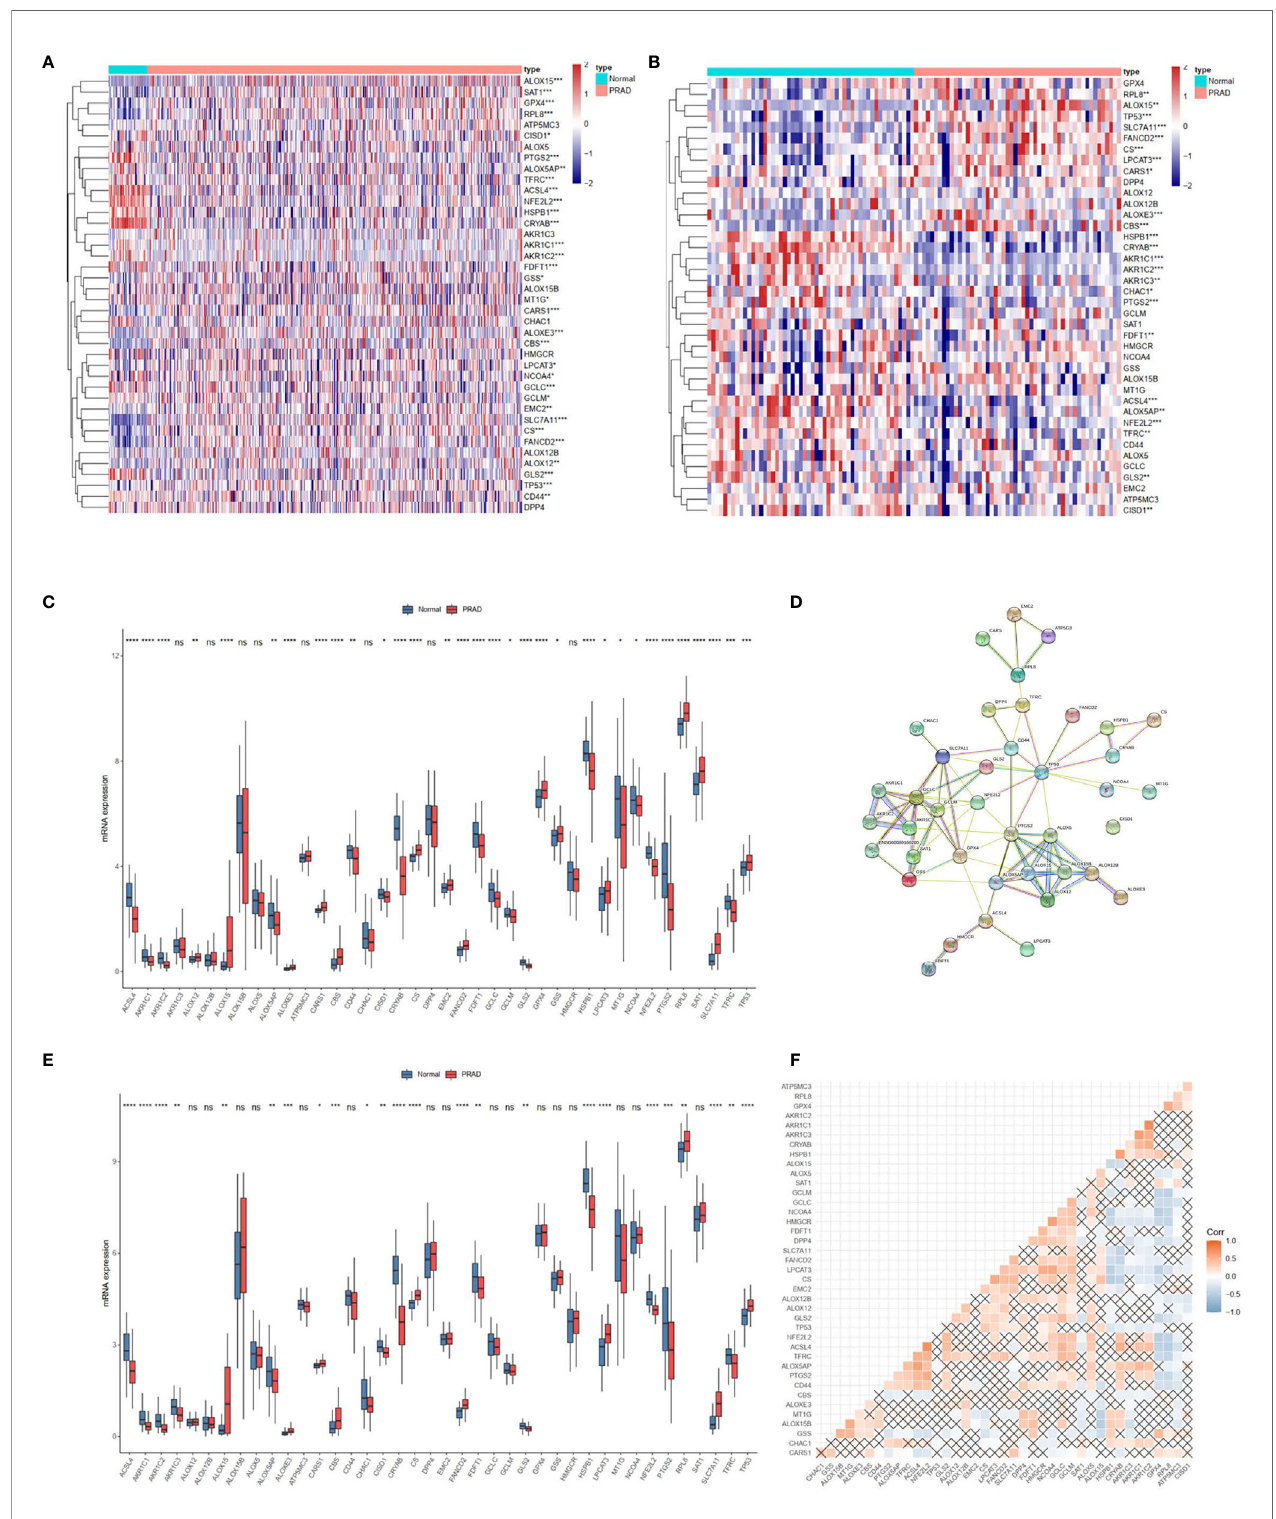
FIGURE 1 | The landscape of ferroptosis-related genes (FRG) in prostate cancer. (A) Heatmap of 40 FRGs between 499 prostate cancer and normal tissues. (B) Heatmap of 40 FRGs between 52 tumor and adjacent normal pairs. (C) mRNA expression levels FRGs levels in total prostate cancer and normal tissues. (D) The PPI network acquired from the STRING database among the FRGs. (E) mRNA expression levels FRGs levels in prostate cancer and paired tissues. (F) The correlation among FRG in prostate cancer. *P < 0.05, **P < 0.01, ***P < 0.001, ****P < 0.0001. ns, not signi fi